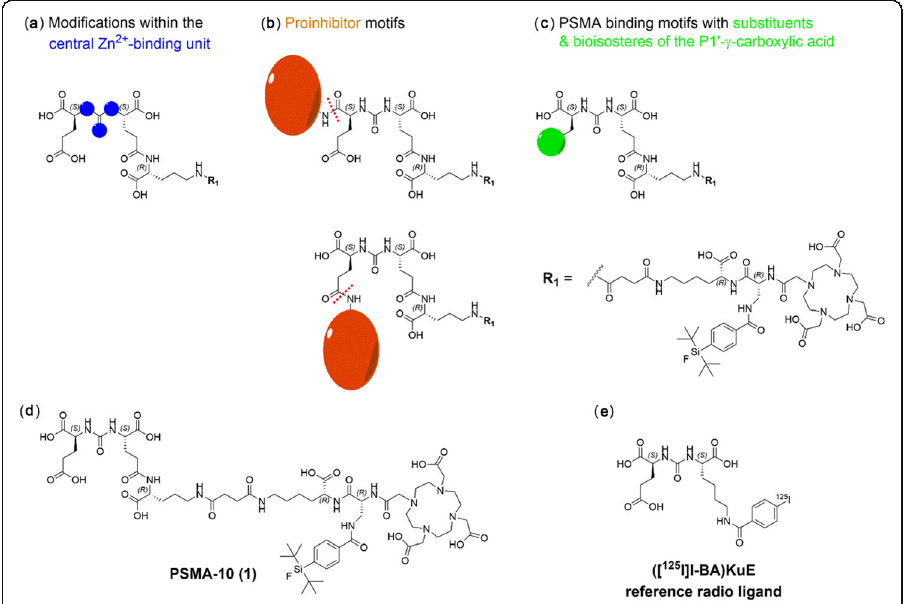
Fig. 1 Schematic representation of PSMA inhibitors containing ( a ) modifications within the central Zn 2+ - binding unit ( b ) proinhibitor motifs (expected cleavage sites are indicated as red dotted lines) and ( c ) substituents & bioisosteres of the P1 ’ - γ -carboxylic acid. All compounds were derived from the EuE-based ligand PSMA-10 ( 1 ) ( d ) which served as a reference for all obtained in vitro and in vivo data. e The reference ligand for IC 50 determinations was ([ 125